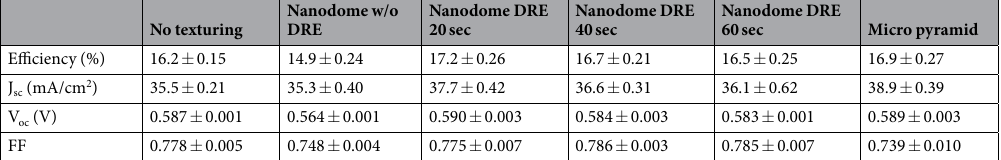
Table 1. Device parameters of solar cells with parabolic Si nanostructures by varying a DRE process time. For a control device, the solar cell based on a planar wafer is presented. The standard deviations are represented together with average